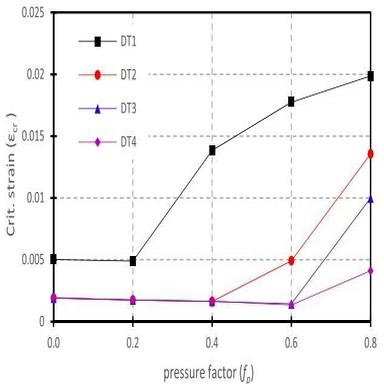
Plot of εcr vs. fp for X70 pipe (YPL = 1.5).